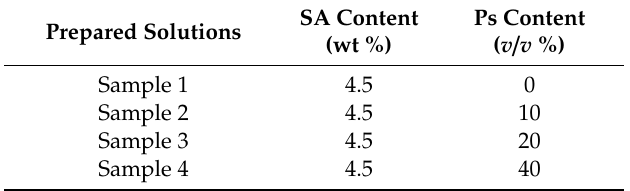
Table 1. The contents of each sample. SA, sodium alginate; Ps,